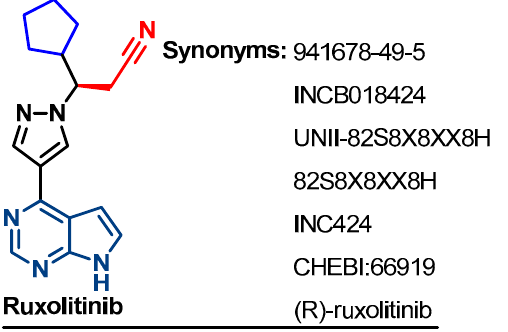
Figure 50. Chemical structure/name/synonyms of ruxolitinib.